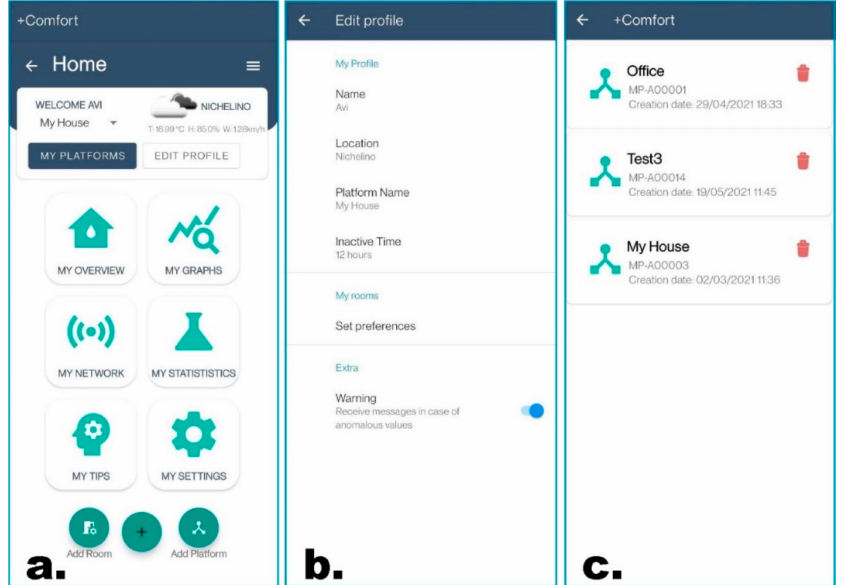
Figure 7. Screenshots of main pages of the developed application: ( a ) homepage; ( b ) profile settings; ( c ) list of platforms connected to the specific user.